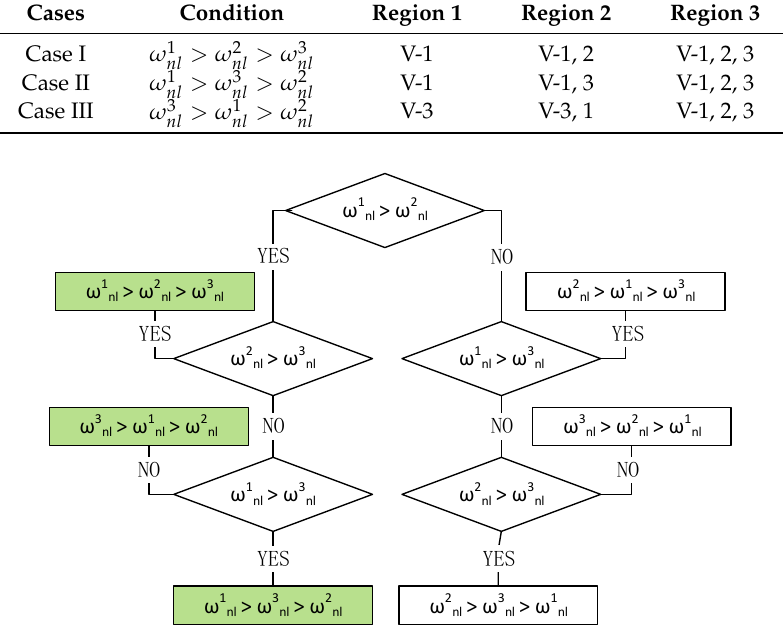
Figure 4. Possible sequences of three VSG sources w.r.t. no-load frequency.